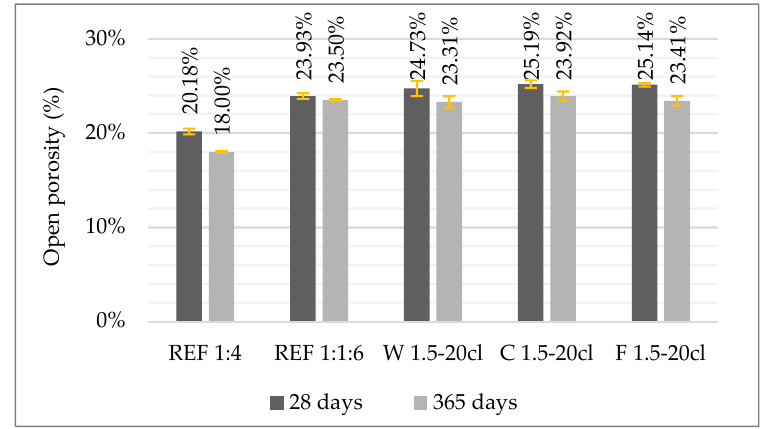
Figure 7. Open porosity of the mortars studied.